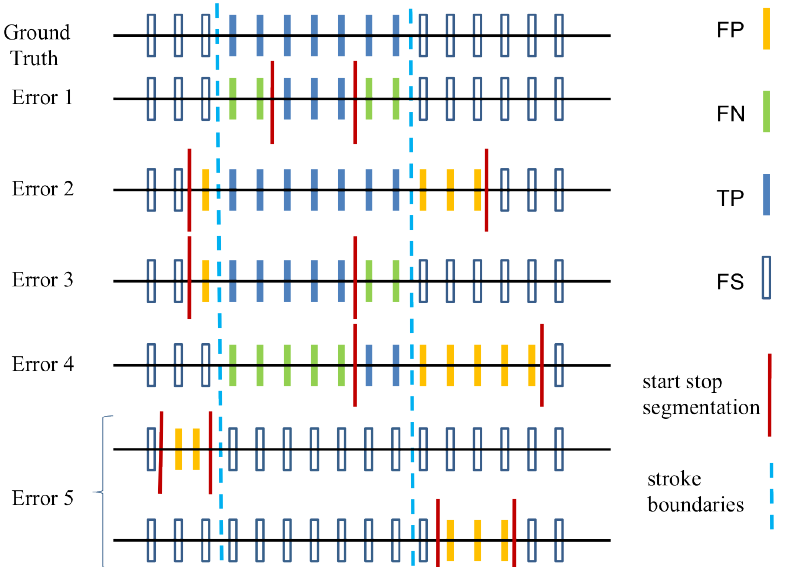
Figure 6. Different possible segmentation errors. Here, FP = False Positive, FN= False Negative, TP= True Positive and FS=outside